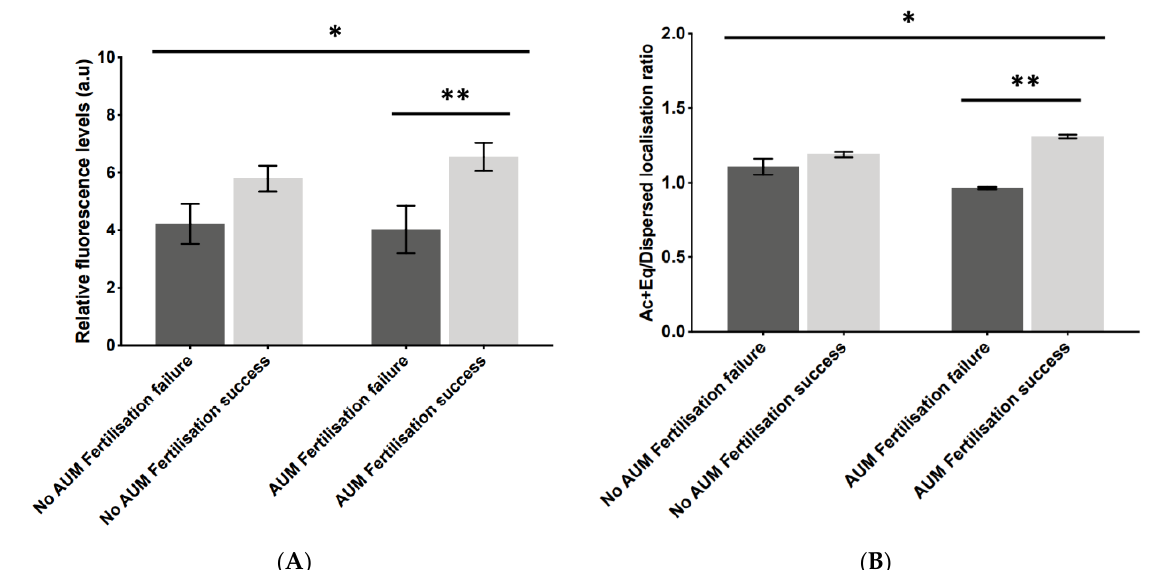
Figure 4. Histograms indicating the differences in ( A ) relative fluorescence levels and ( B ) acrosomal + equatorial/dispersed localisation pattern ratios of PLCζ in cases of fertilisation failure (dark bars) compared to cases of fertilisation success (light bars), in the same cases without (left-hand bars) and with (right-hand bars) antigen unmasking (no AUM and AUM, respectively). Asterisks (*, **) indicate a statistically significant ( p ≤ 0.05) difference. Data are indicative of 100 cells examined from 55 patients each for both AUM and no AUM groups. a.u.: arbitrary units.